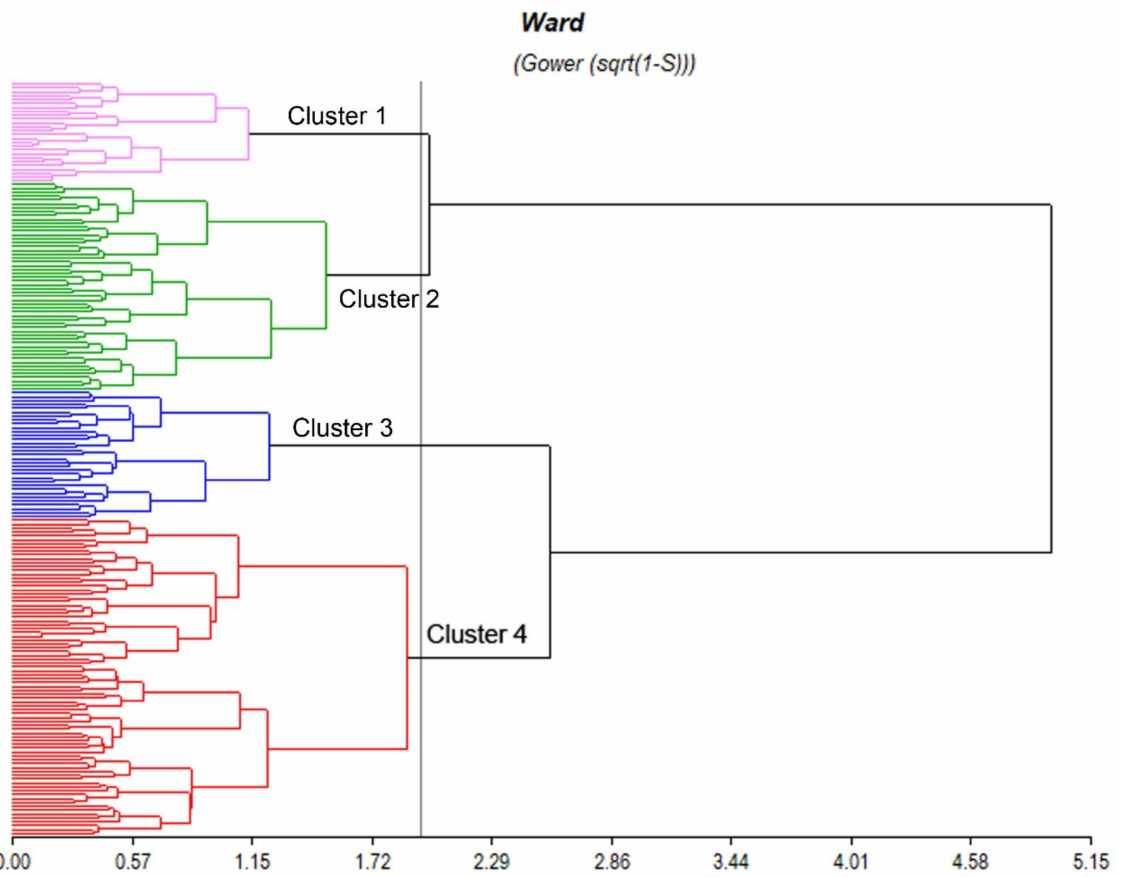
Figure 1. Dendrogram of 195 accessions of Manihot esculenta , indicating four groups of accessions based on quantitative morphological data using Ward’s method and Gower’s